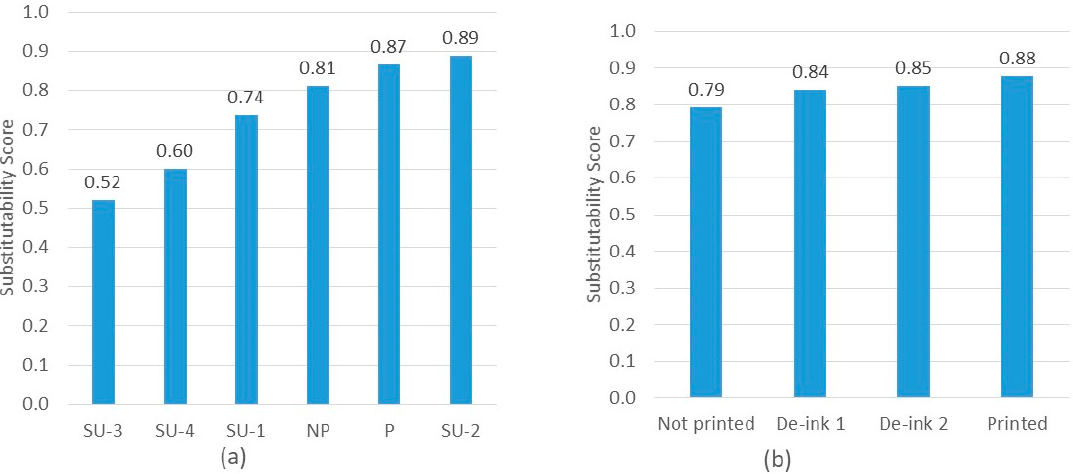
Figure 10. Substitutability score of the LDPE recyclates from ( a ) the scaled-up experiment of this study and ( b ) calculated from the data in [40]. study and ( b ) calculated from the data in